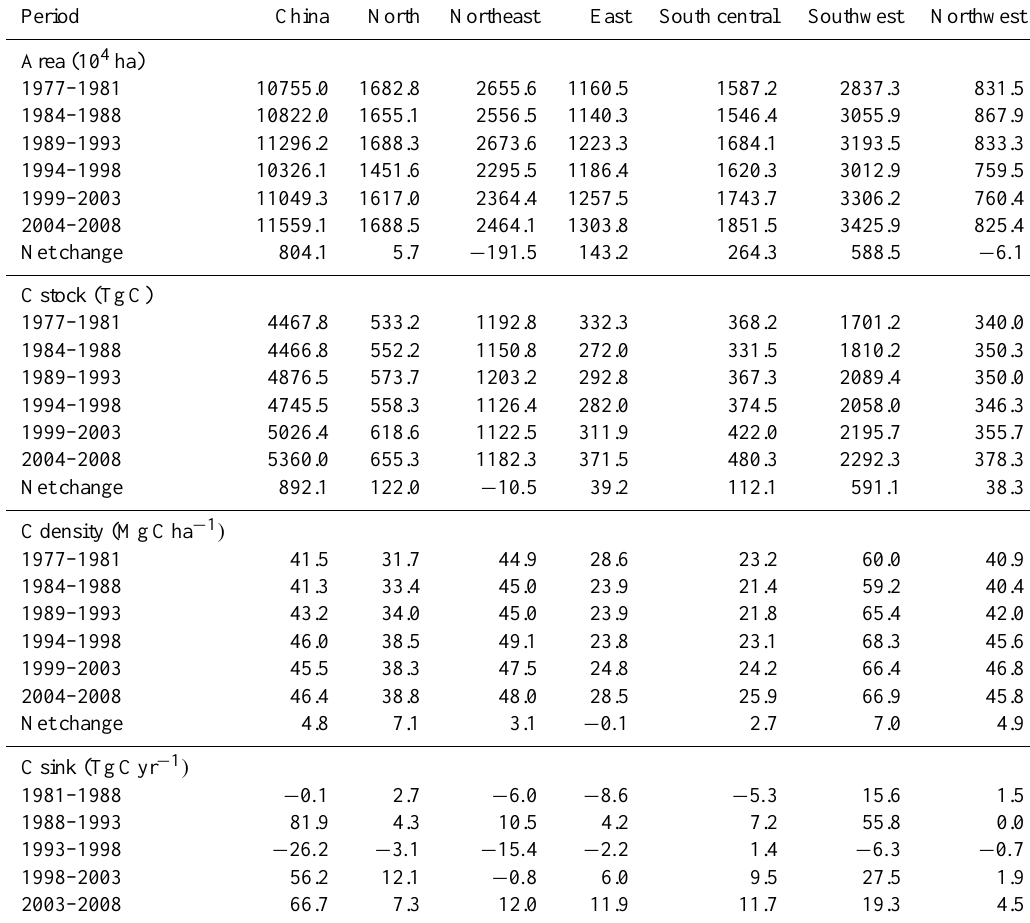
Table B1. Forest area, carbon stock, and carbon sinks of natural forests for six regions in China from 1977 to 2008.